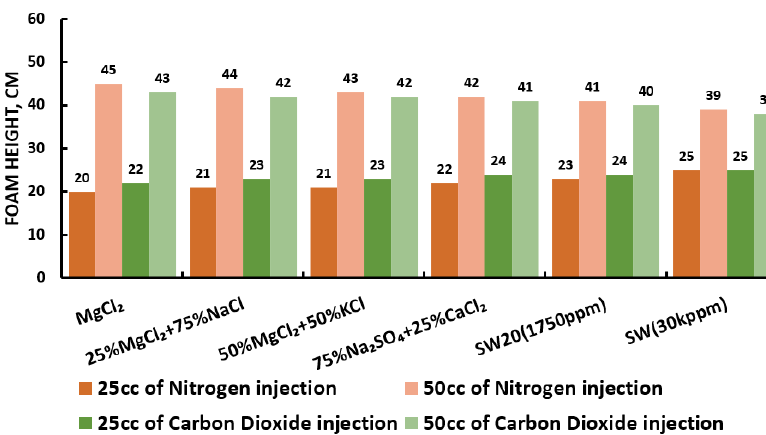
Figure 28. Surfactants screening: formability test—DTAB 25 ◦ C.